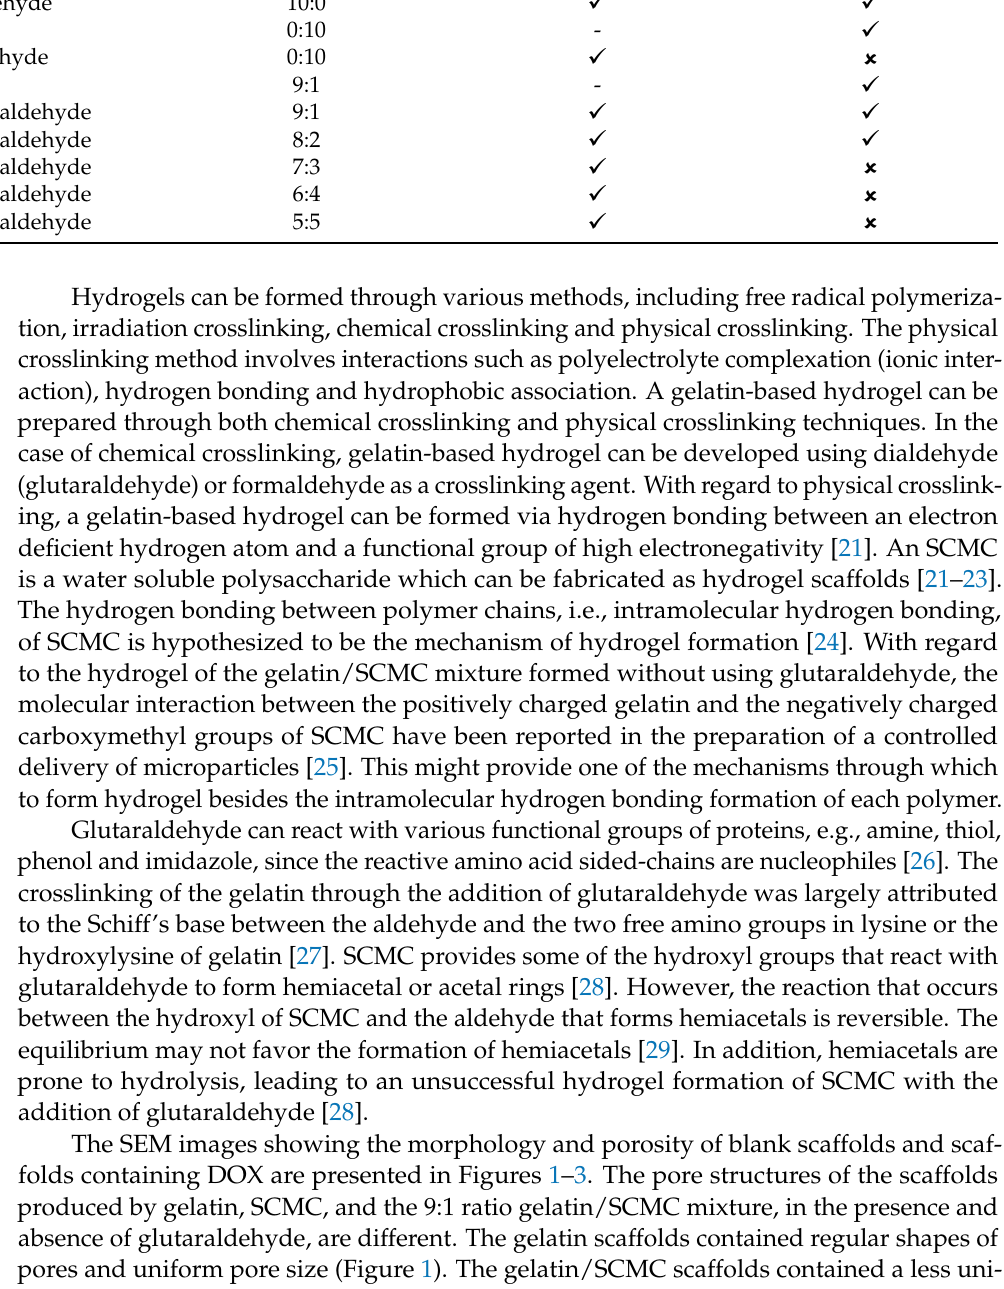
Table 1. Formation of scaffold prepared from gelatin, sodium carboxymethyl cellulose, and gelatin/SCMC mixture. Sample Name